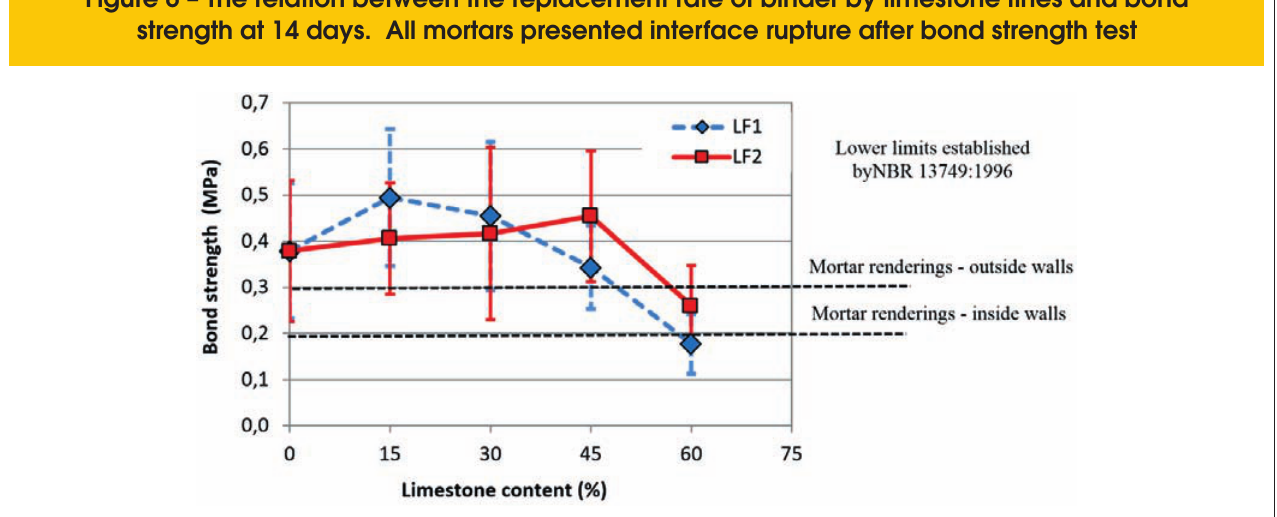
Figure 7 – Independent repetition of bond strength test made for mortars with 0%; 45% and 60% of replacement of binder by limestone fine 2 (LF2) using the same materials, mixing procedures, application and cure procedures and equipment, but different operators to check the experimental error. The results showed the same trend and the difference between the average of repetitions was less than